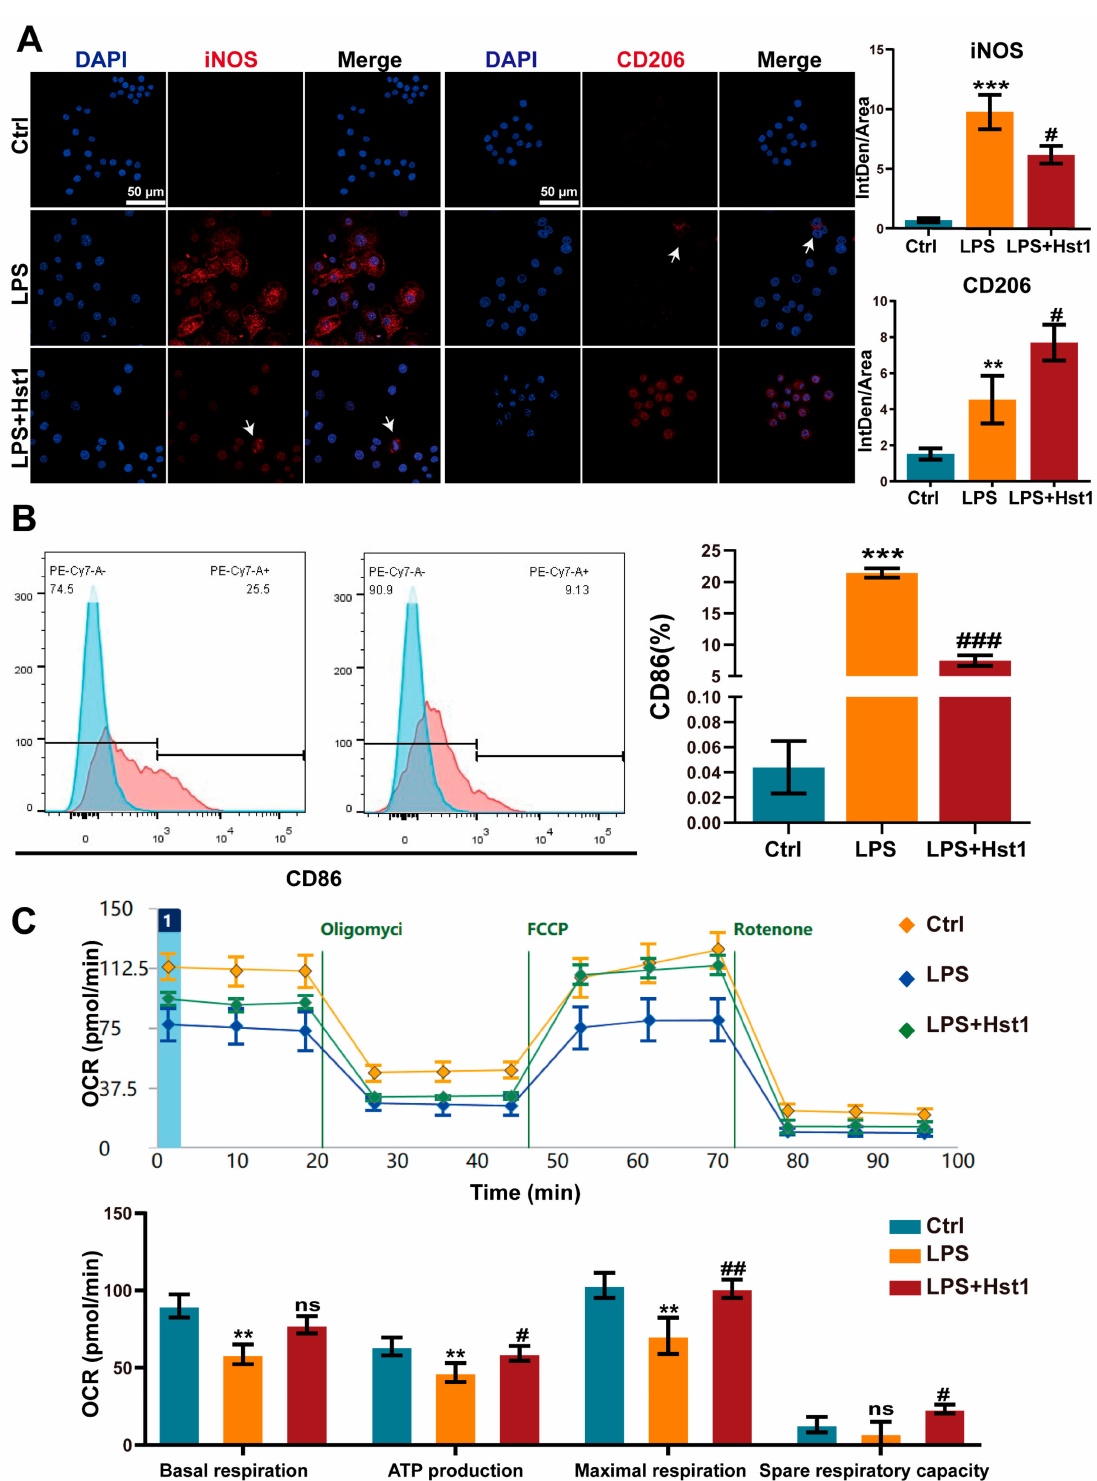
Figure 5. Effects of Hst1 on the polarization phenotype of macrophages. ( A ) The M1 macrophage marker iNOS and M2 macrophage marker CD206 were incubated with primary antibody and observed using confocal microscopy, n = 3; scale bar = 50 µ m. ( B ) M1 macrophage subsets evaluated using flow cytometry and by staining CD86, n = 3. ( C ) Energy metabolism of macrophages analyzed using seahorse analysis, n = 4. Data are expressed as means ± SD from ≥ three independent experiments. Significant differences compared to the control group: ** p < 0.01, and *** p < 0.001, and compared to LPS group: # p < 0.05, ## p <0.01, and ### p < 0.001; ns: not